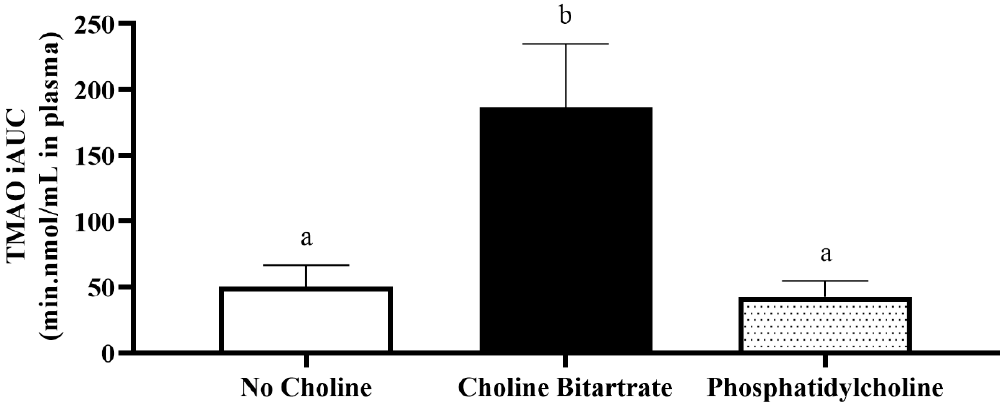
Figure 3. Plasma trimethylamine- N -oxide (TMAO) response to study meal consumption as incremental area under the curve (iAUC) across the 6-h study period. Different letter superscripts show a significant effect of study meal (one-way ANOVA, Tukey-Kramer post hoc test; p = 0.01). Values are mean ± SEM, n = 37 per study meal.